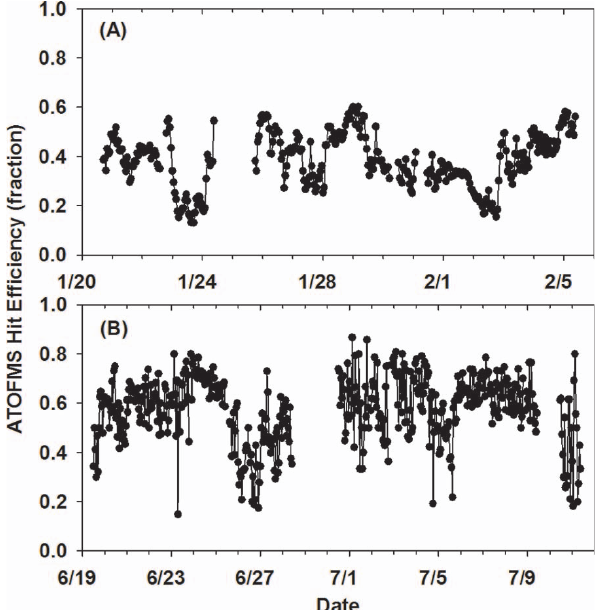
Fig. 3. ATOFMS hit efficiency for particle smaller than 0.52µm in Toronto (A) and Harrow (B)